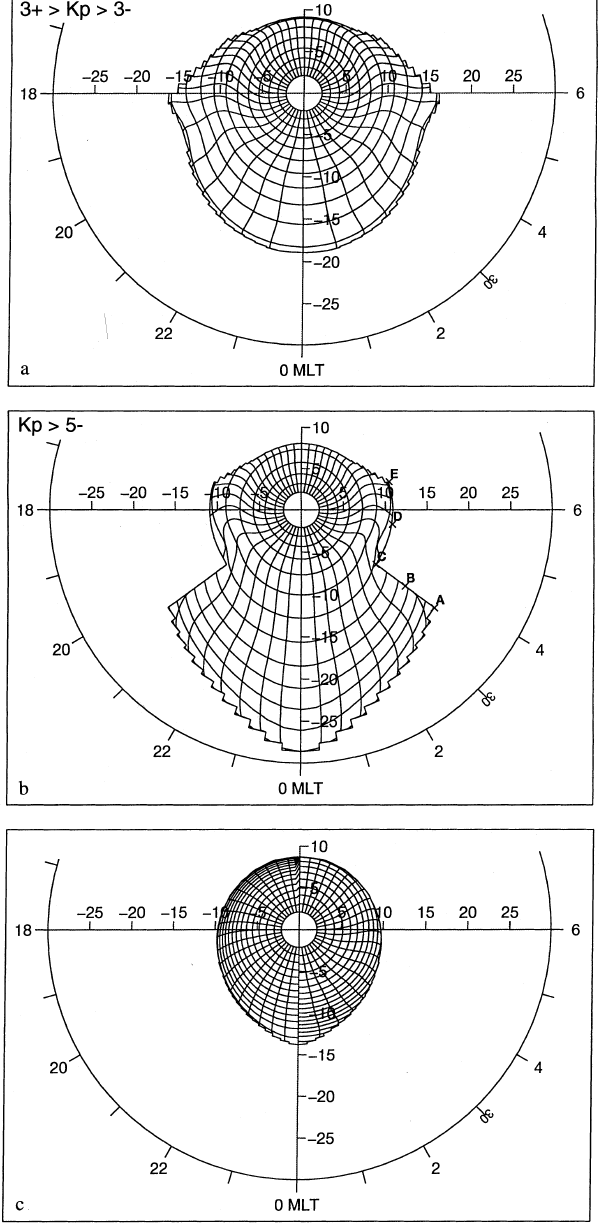
Fig. 3a–c. Contours of the Euler potentials in the equatorial plane of the magnetosphere between the Earth’s centre and 30 R e with the Magnetic Local Time indicated on the external circle a for 3 (cid:255) < Kp < 3 (cid:135) and b for 5 (cid:255) < Kp . The a contours are represented as contours of the equivalent L parameter. They encircle the Earth while the b contourscrossthem.The contourintervalis 1for L with the closest contour to the Earth corresponding to 2, and is (cid:133) 2 p R e = 40 (cid:134) for b with b (cid:136) 0 in the midnight meridian c Contours of the Euler potentials in a format similar to a, b . The dusk sector (1200 < MLT < 2400) corresponds to the Euler potential inferred by Stern (1967). The dawn sector illustrates the Euler potentials that we compute from the volume # of the Stern (1967) magnetic In Fig. 3a, b, the contours of a are represented by 2 the corresponding contours of equivalent L , from L (cid:136) 2 and steps of one unit. Close to the Earth, they are circles around the Earth as for a dipole. The only di(cid:128)erence is a L -value smaller than the radial distance: